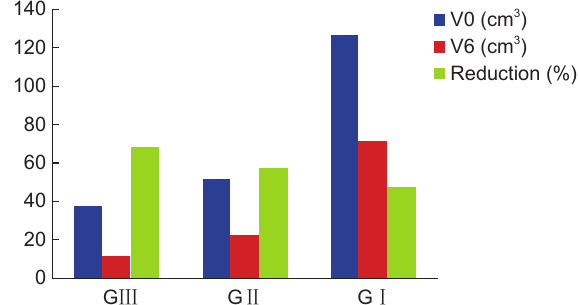
Figure 4 Changes in fibroid volume among groups of different grades before and 6 months after treatment. V0, fibroid volume before treatment; V6, fibroid volume at 6-month posttreatment; Reduction shows interclass comparison of the uterine fibroids volume before and 6 months after